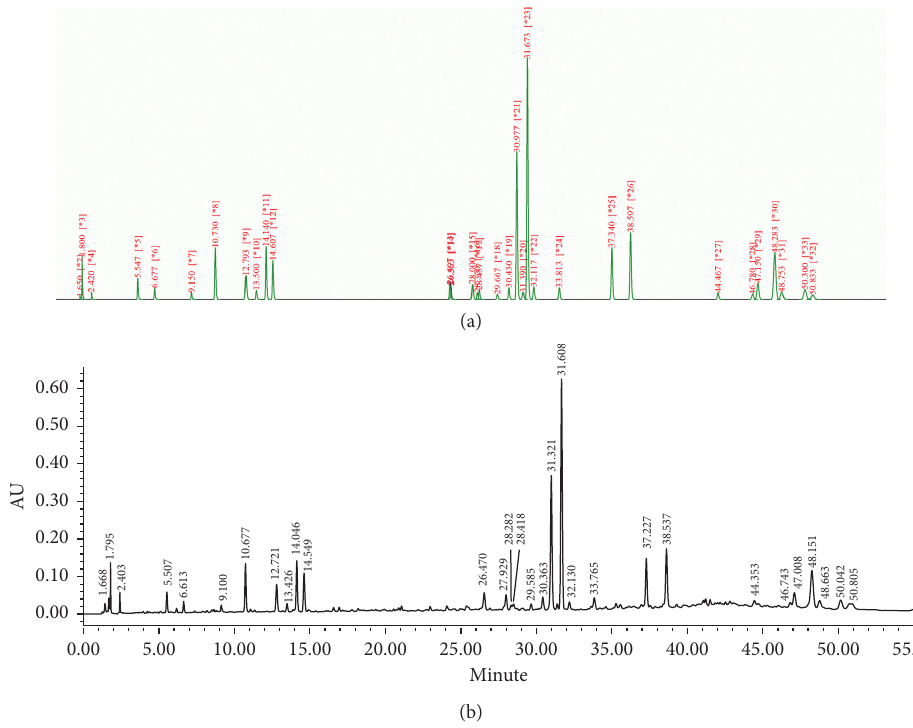
Figure 3: The simulated chromatogram (a) and the verification chromatogram (b) under the predicted elution gradient: 0–40 min, 12%–98% A and 40–55 min, 98%-98%